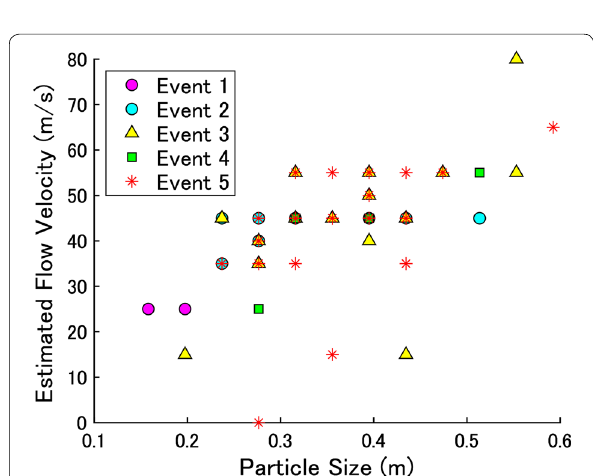
Fig. 9 Plots of estimated flow velocity against particle